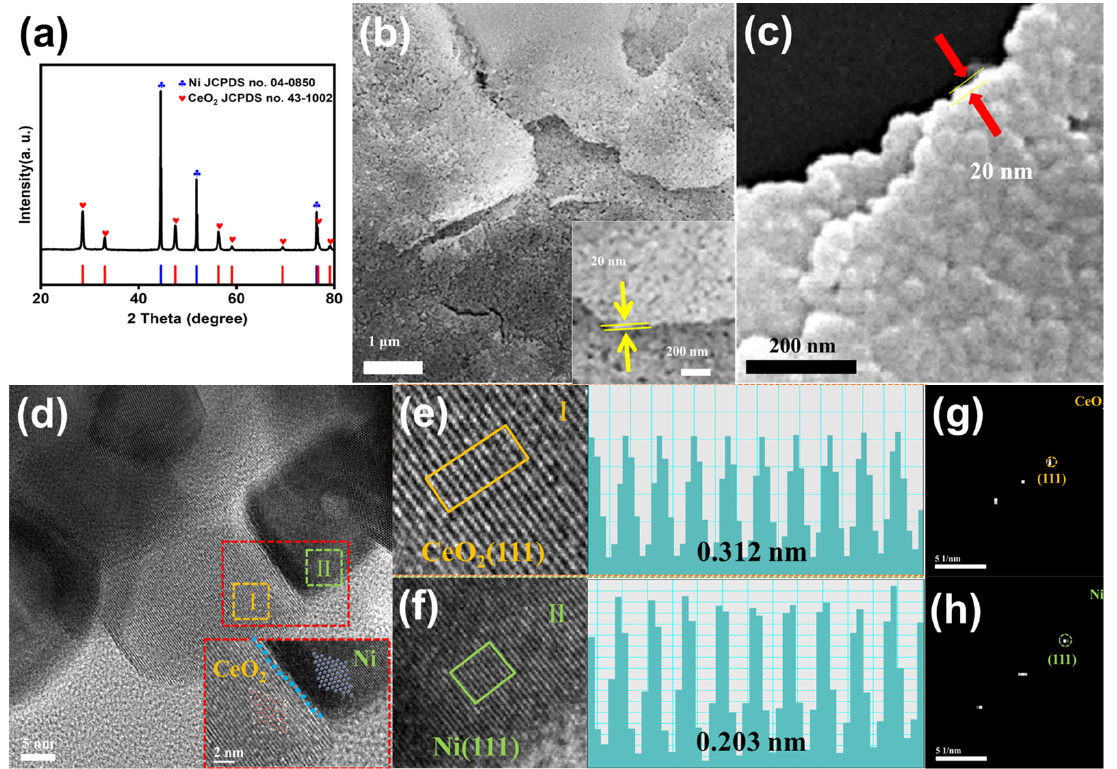
Figure 2. Morphological characterization of the formed Ni/CeO 2 HJ ‐ NSs. ( a ) XRD pattern, ( b , c ) SEM images, with the inset in ( b ) showing SEM image of side view of Ni/CeO 2 HJ ‐ NSs. ( d – f ) HRTEM images, the red dotted box of the inset of ( d ) is an enlarged view of the interface in Ni/CeO 2 HJ ‐ NSs. ( g , h ) FFT images of orange dotted box (I zone) and light green dotted box (II zone) in ( d ).